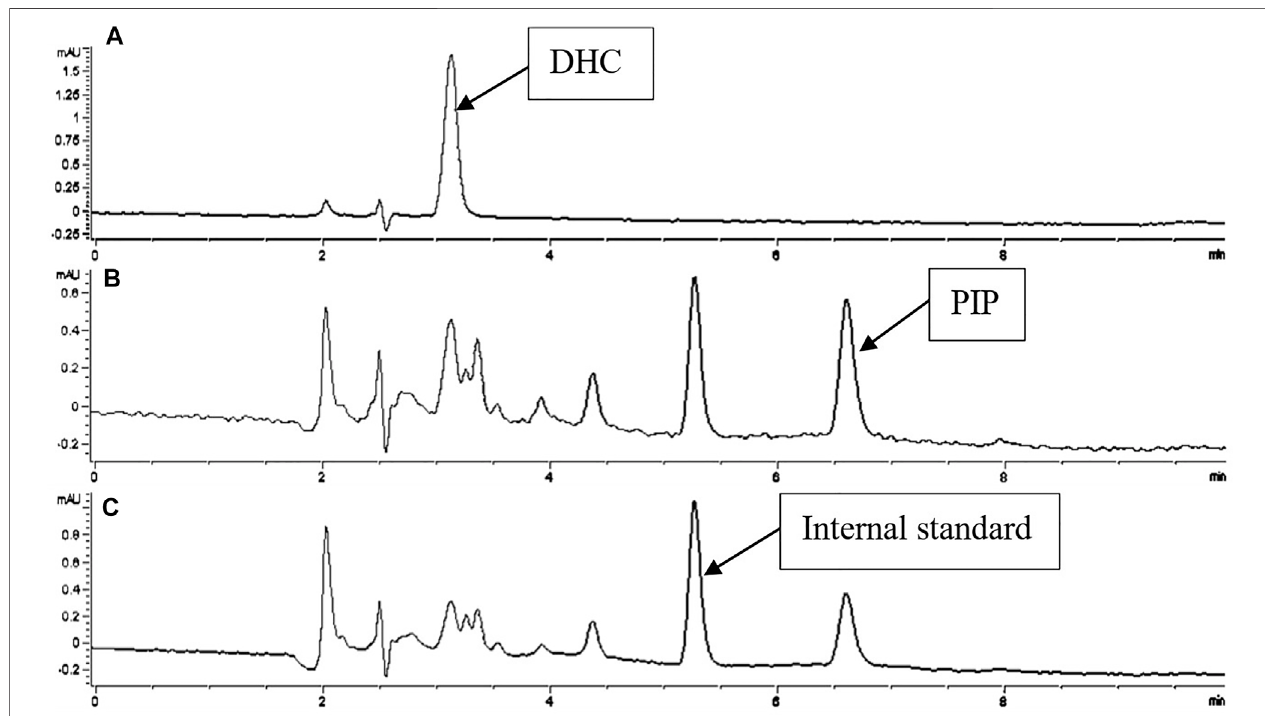
FIGURE 2 | Chromatogram of DHC and PIP in biological samples with ILE as internal standard. Detections of A, B, C were recorded at 420, 340, 323 nm.